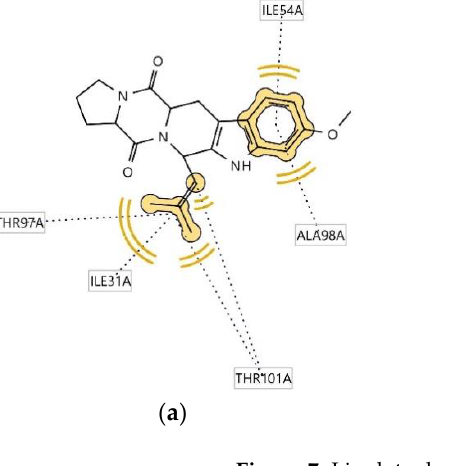
Figure 7. Ligplots showing interacting residues of l-lactate dehydrogenase complex with compounds 1 ( a ) and 2 ( b ). Red arrow dotted lines, HBAs; green arrow dotted lines, HBDs; yellow lines, H interactions.